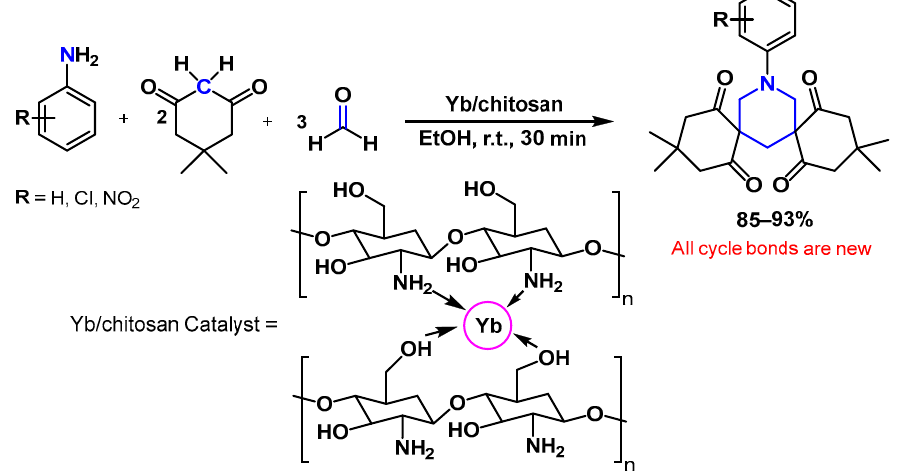
Figure 3. Synthetic piperidine derivatives in medicine.